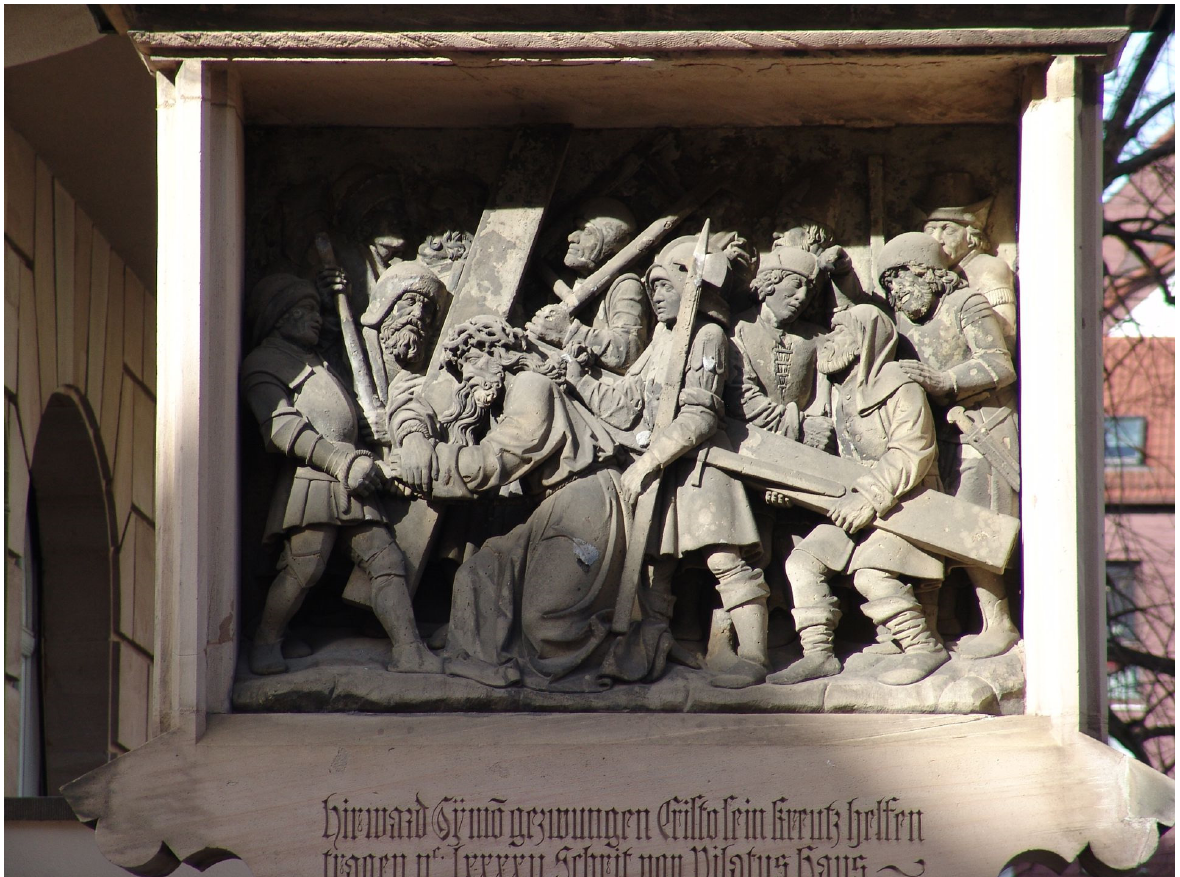
Figure 16. Kraft, Stations of the Cross , Nuremberg, Station Two (reconstruction).